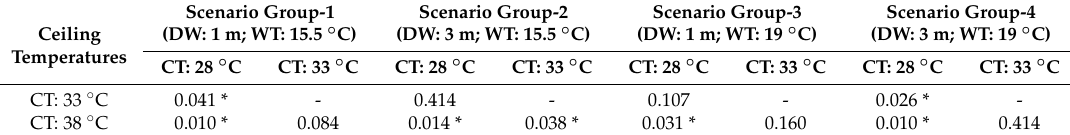
Table 5. Results from the Wilcoxon signed rank test for the overall thermal sensation at four scenario groups given in Table 4. WT and DW stand for the window temperature and distance to the window, respectively. Ceiling